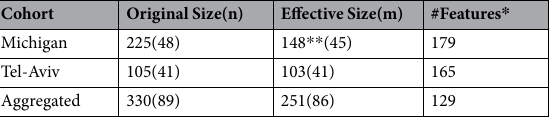
Table 2. A summary table, with selected feature pair correlations, separately for each of the three datasets used in the study. The values in parentheses represent the numbers of patients that had falls. * Number of features after preprocessing. ** 77 healthy controls were